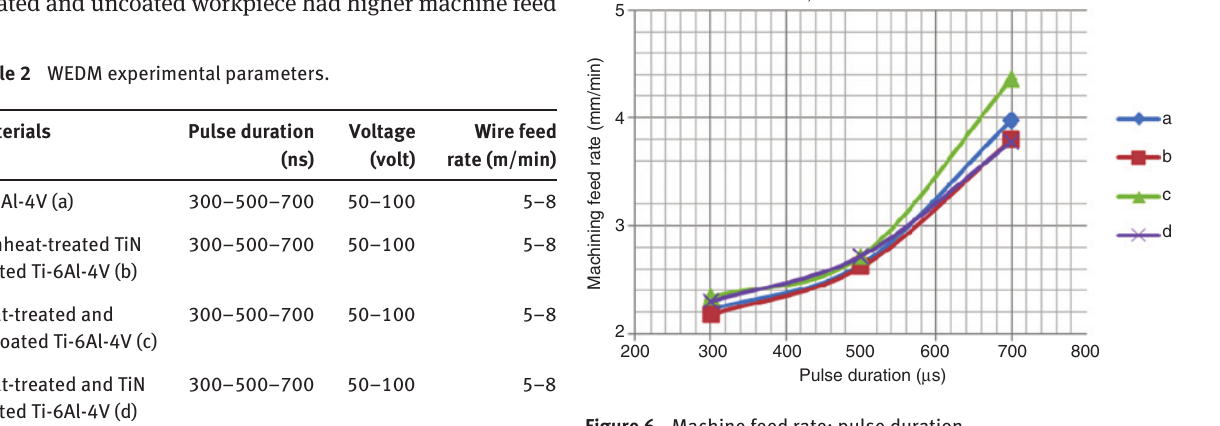
Figure 6 Machine feed rate: pulse